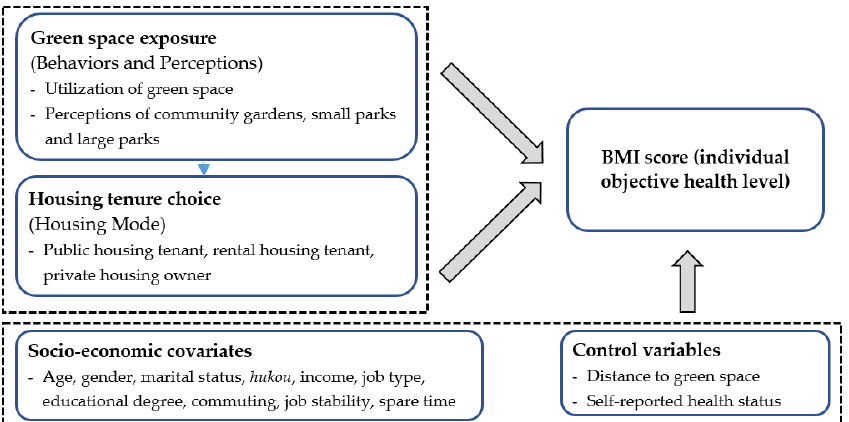
Figure 1. Theoretical framework.